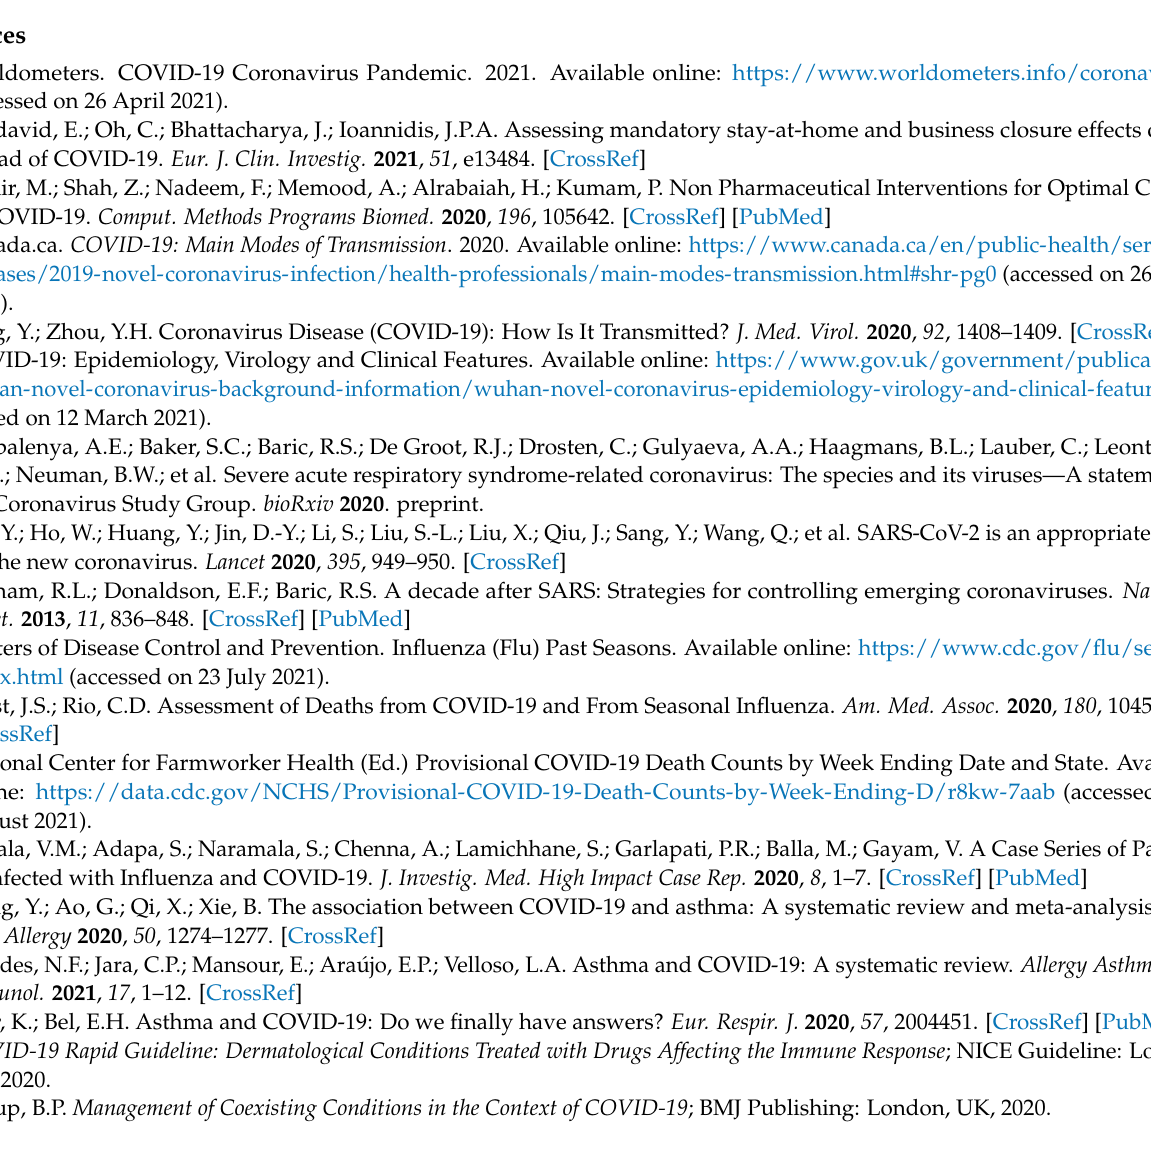
for Figure 4: Remdesivir for the Treatment of COVID-19—Final Report [139], Baricitinib plus Remde- sivir for Hospitalized Adults with COVID-19